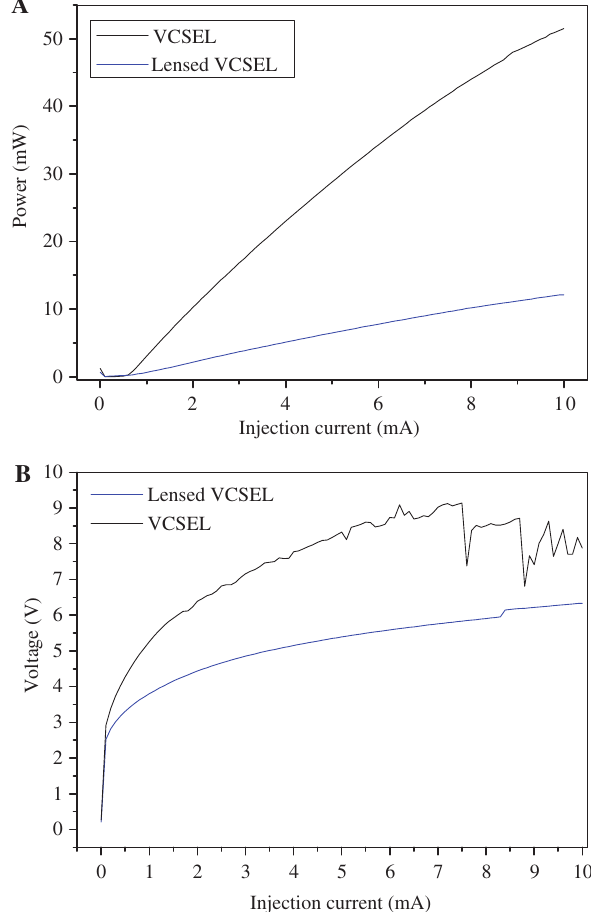
Figure 9: Comparison of characteristics of the VCSELs with and without the